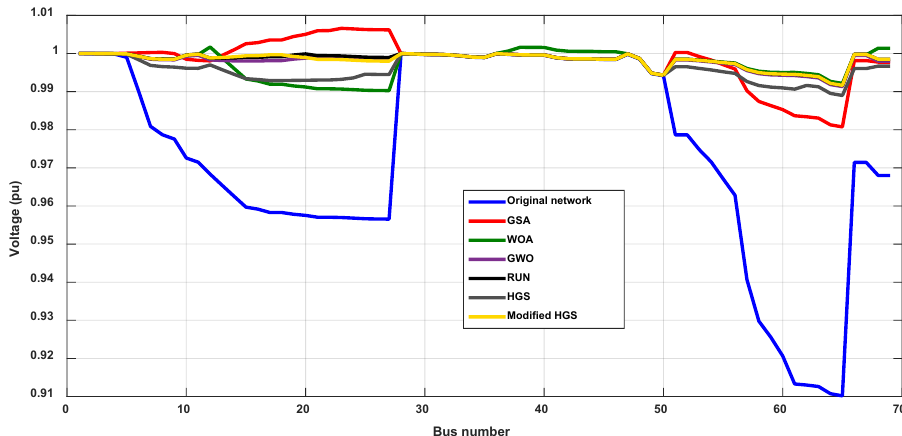
Figure 8. IEEE 69-bus network voltage profiles with and without BDGs.